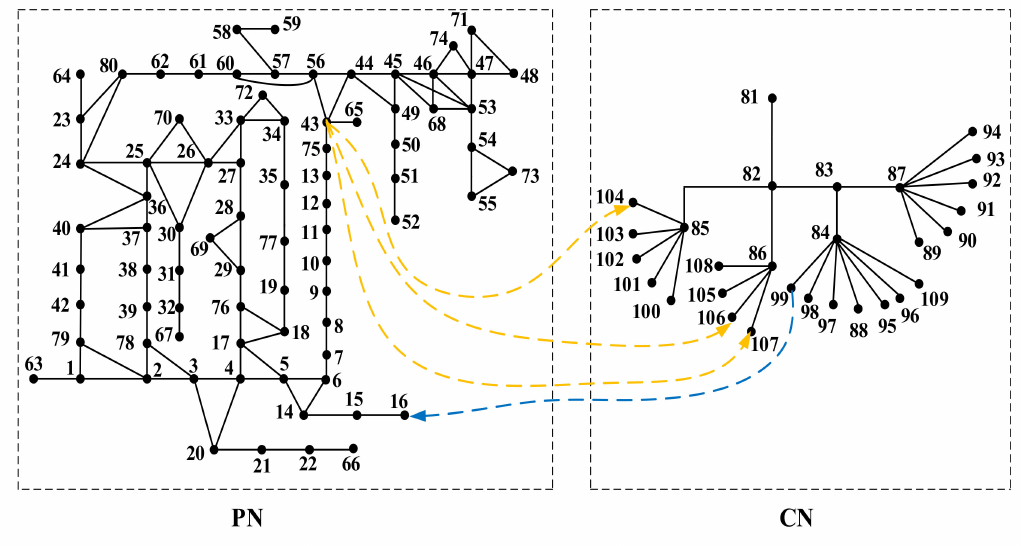
Figure 4. Topology and node numbering of PN and CN in the